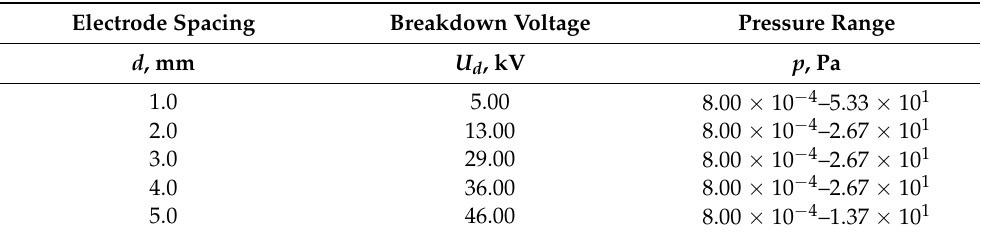
Table 5. Measured values of breakdown voltages U d in a compartment with constant dielectric strength for a vacuum interrupter with residual gases being helium.